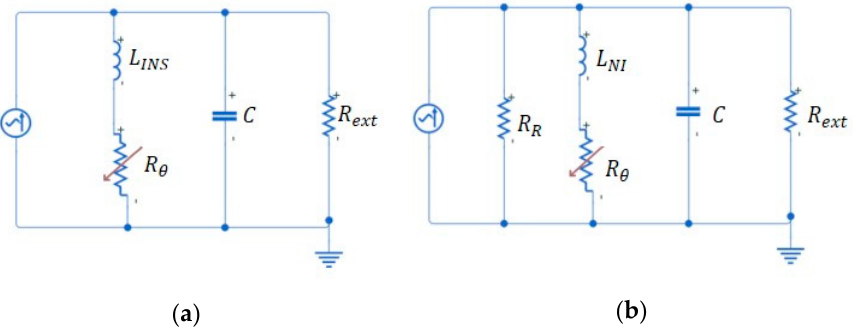
Figure 9. Equivalent circuit to explain the filter characteristics according to the shape of the transfer function: ( a ) INS coil and ( b ) NI coil.